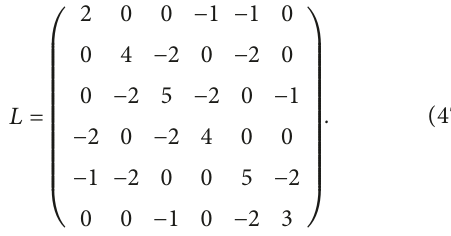
i, 1 via protocol